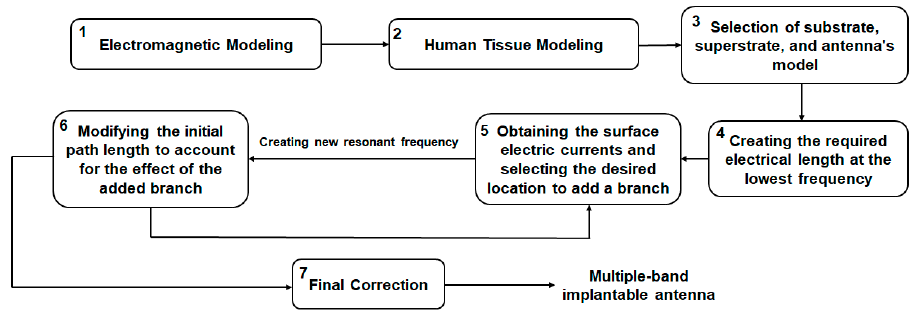
Figure 3. Flowchart procedure for design of a multiple ‐ band implantable antenna.